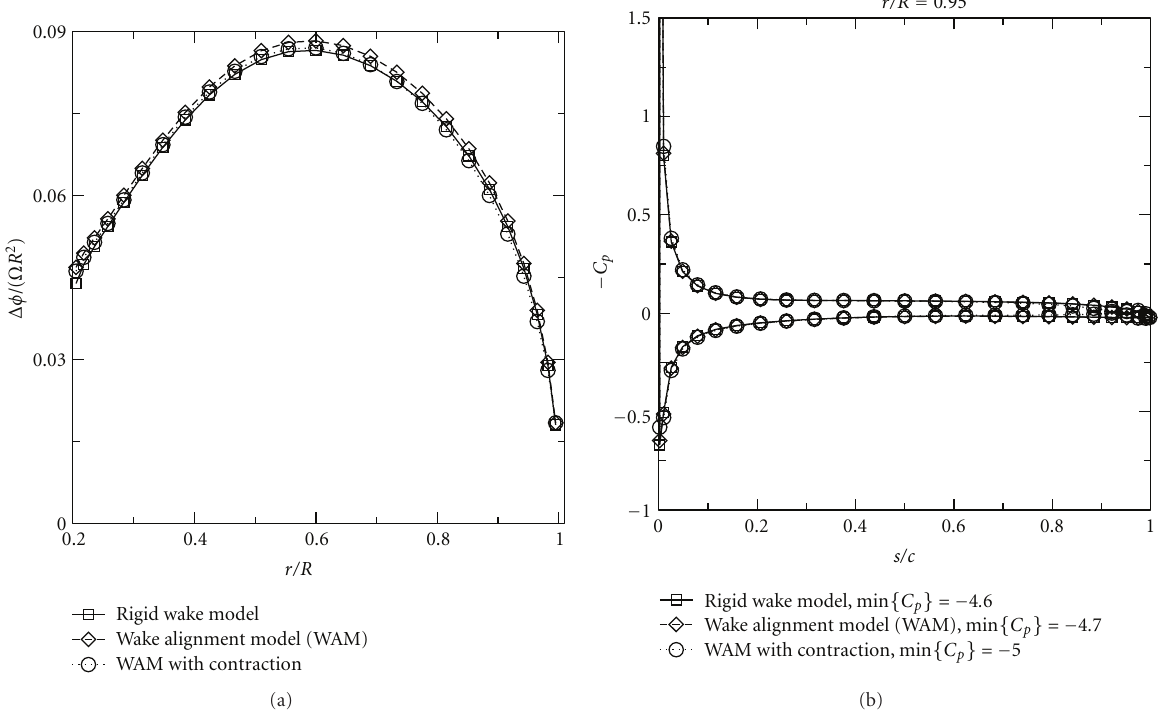
Figure 7: Radial circulation (a) and chordwise pressure (b) distributions. Propeller Ka4-70 at J = 0 . 5. Influence of the wake model.